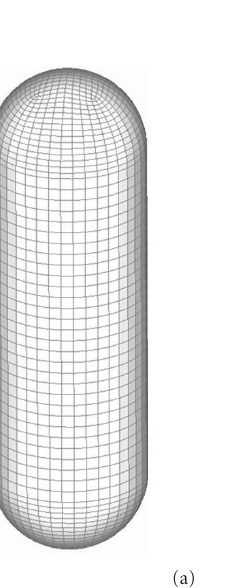
Figure 7: (a) FEM mesh model of the vessel using shell elements. (b) Main dimensions and principal maximum stresses at the outer surface are shown.